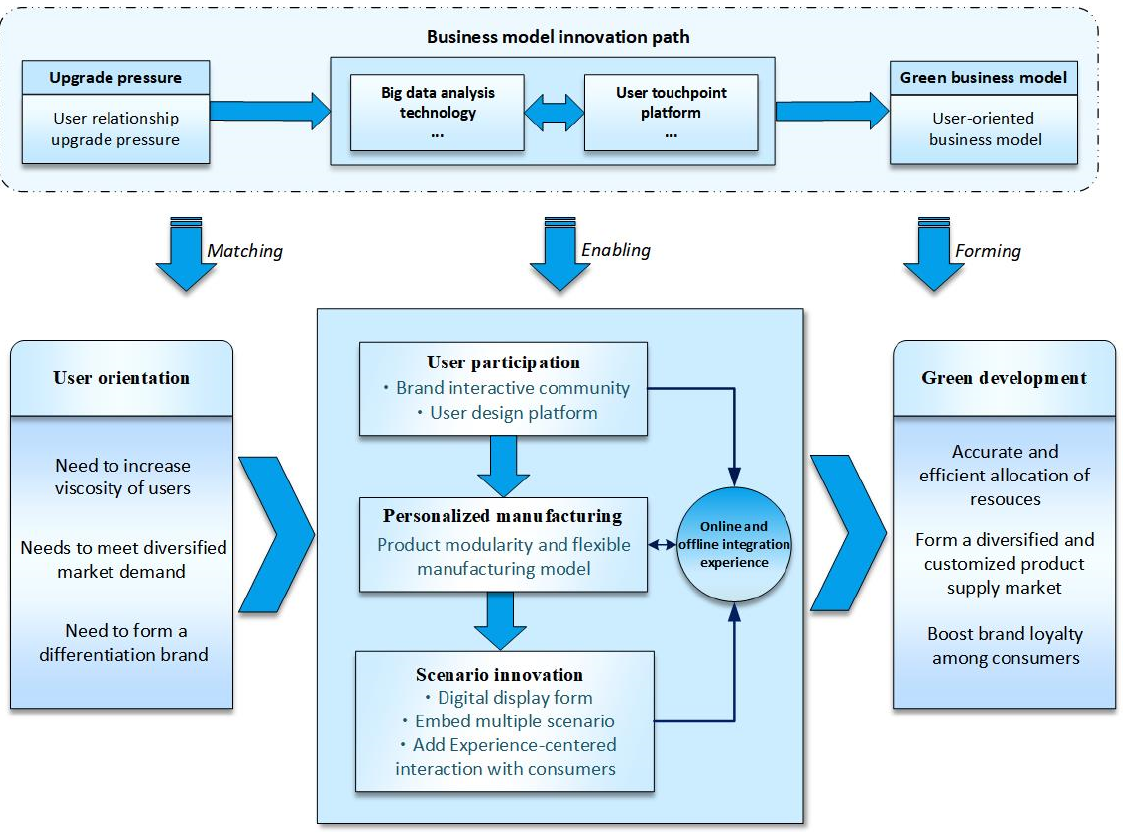
Figure 6. Conceptual model of the user-oriented path.